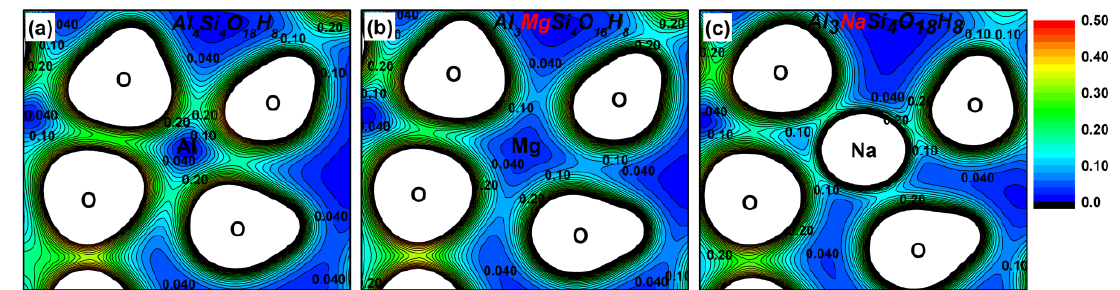
Figure 4. The charge density distribution of the undoped kaolinite and doped kaolinite. The spacing between each contour line is 0.02 eV. ( a ) The O 2 –Al 2 –O 5 plane in the undoped kaolinite (Al 4 Si 4 O 18 H 8 ), ( b ) the O 2 –Mg–O 5 plane in the Mg-doped kaolinite (Al 3 MgSi 4 O 18 H 8 ), ( c ) the O 2 –Na–O 5 plane in the Na-doped kaolinite (Al 3 NaSi 4 O 18 H 8 ).